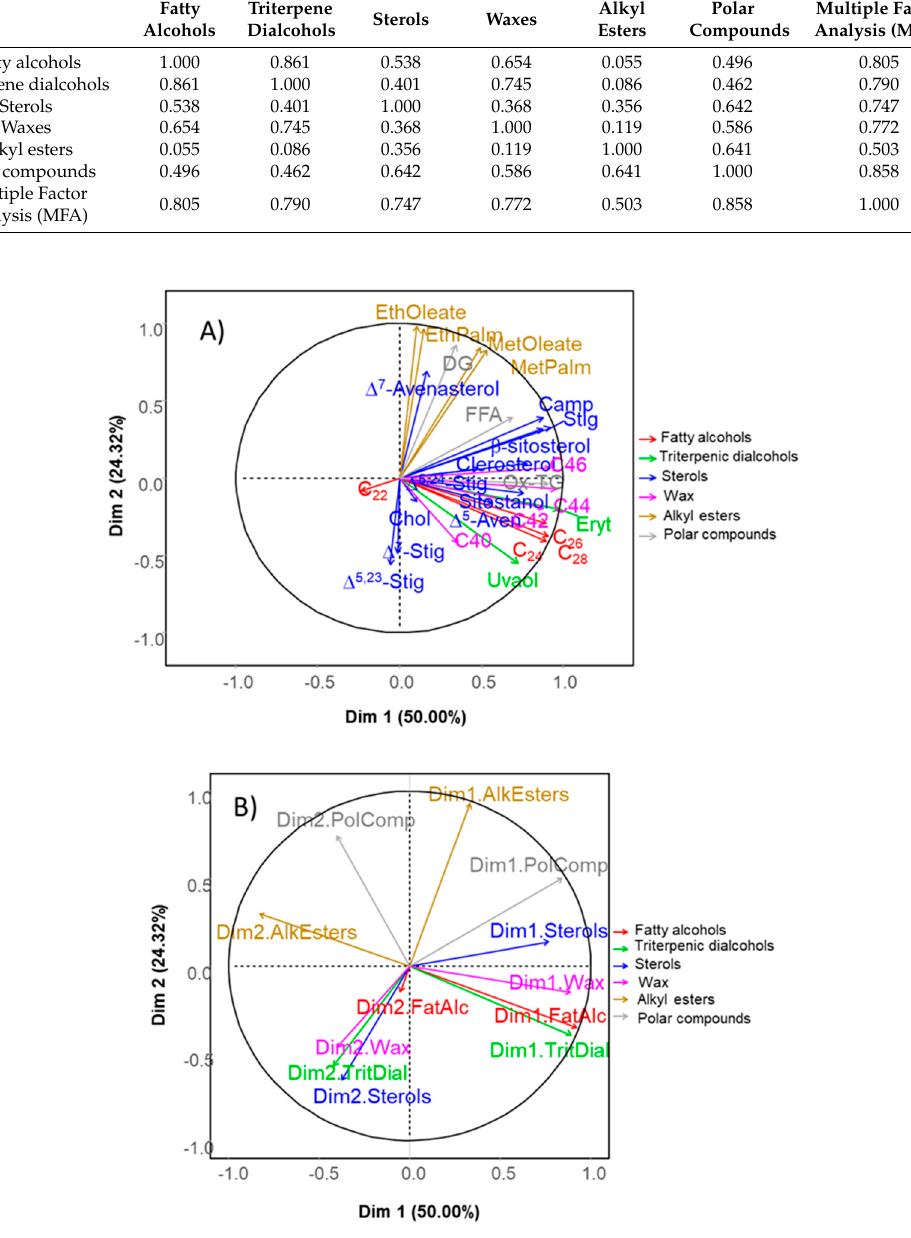
Figure 5. A study, based on the original data of the changes, according to processing phases and extraction method in the minor components in green Spanish-style fat using Multiple Factor Analysis (MFA): a correlation circle for groups and individual components ( A ) and between the first two dimensions of MFA and PCA of the groups’ components ( B ). See Table 1 for abbreviations.